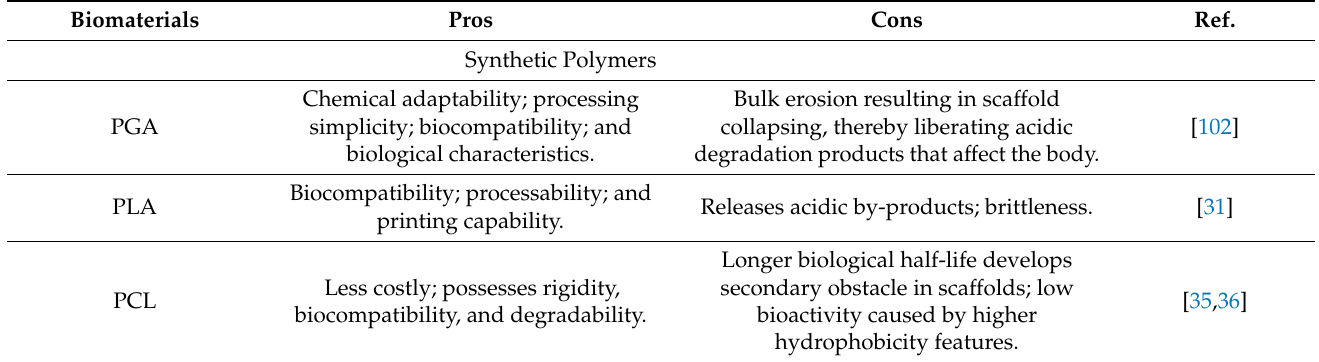
Table 1. Overview of pros and cons of common polymers in 3D bio-printing application.